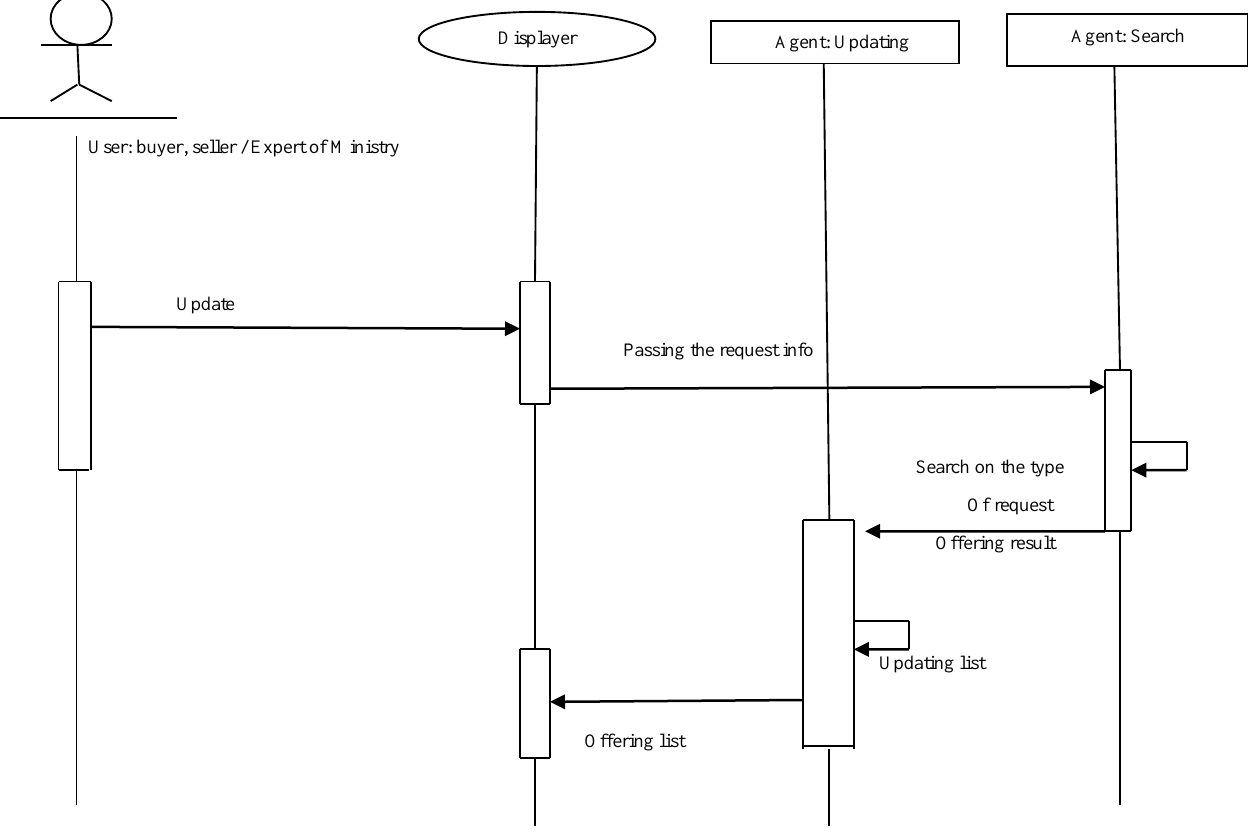
Figure 10. Interaction model on the updating role.